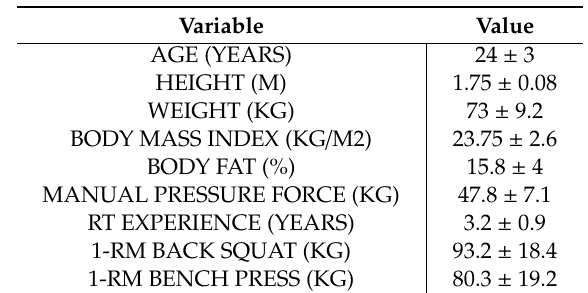
Table 1. Descriptive characteristics and anthropometric data of participants.